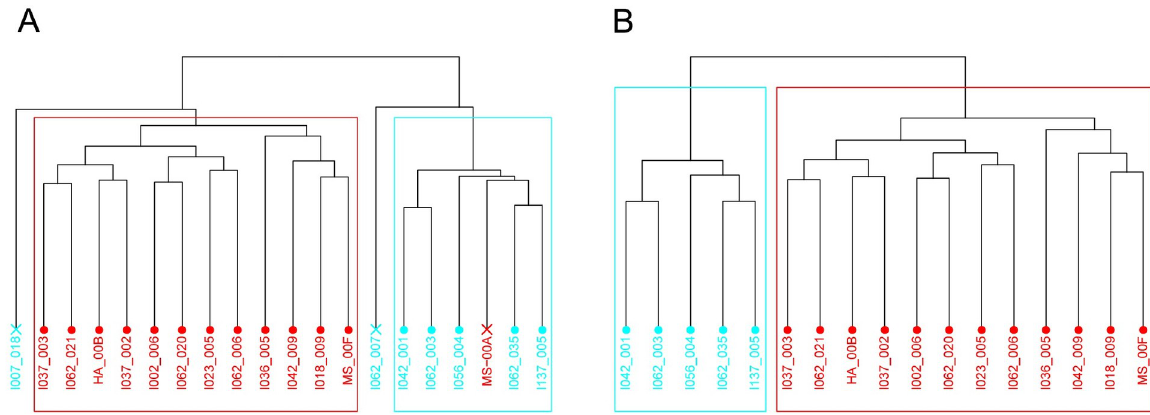
Fig 4. Dendrogram showing the results of our hierarchical cluster analysis of (A) 20 RNA-Seq samples selected from two thirds top and bottom of the OS sample list arranged according to PGC score; and (B) 17 remained RNA-Seq samples used for DE analysis and GSEA. BRCAness-positive samples are denoted by red color and BRCAness-negative by cyan color. Leaves representing excluded samples are denoted with ’x’. The demarcated boxes in red and cyan represent two groups obtained by cutting the dendrogram at even height and used further in DGE and GSEA. The height of a group is defined by Ward’s